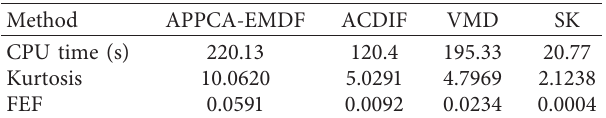
Table 7: The comparison results of APPCA-EMDF, ACDIF, VMD, and SK methods in experimental case 1. Method